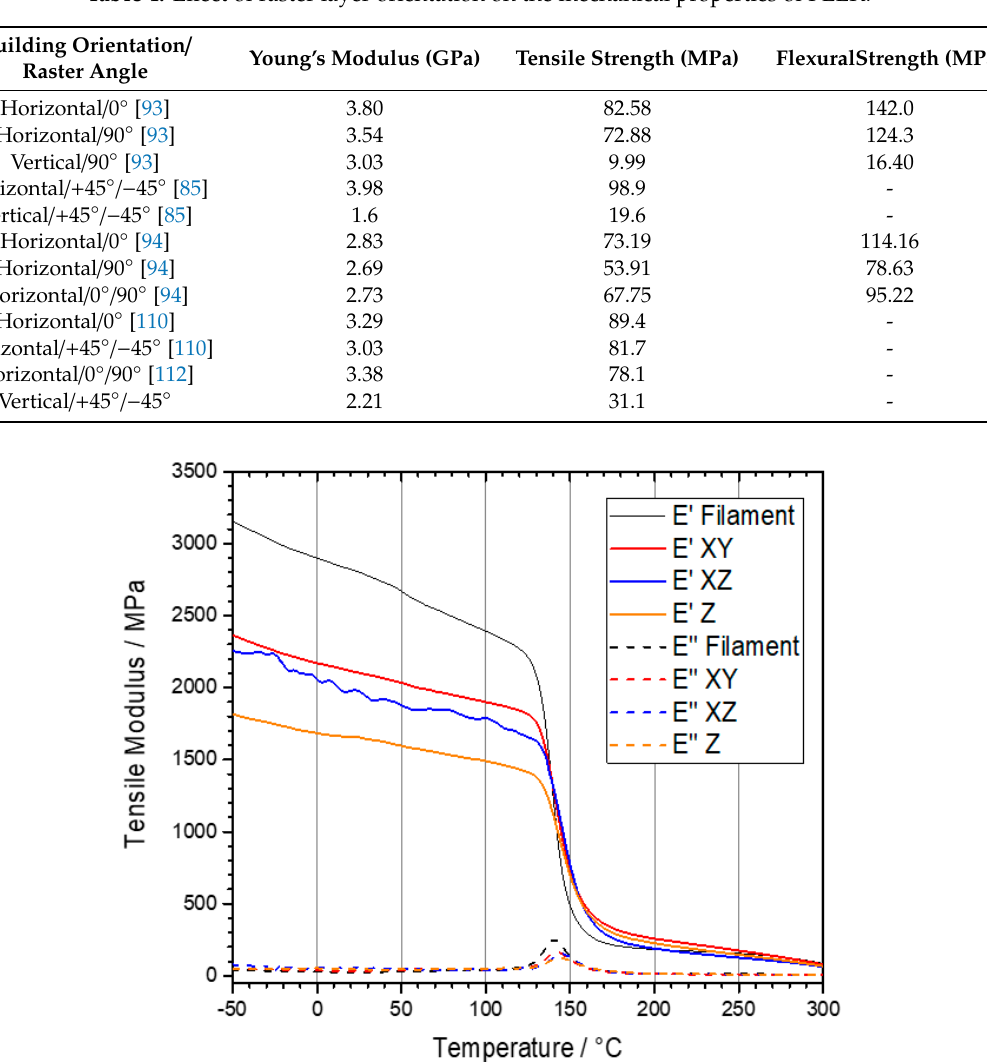
Table 4. Effect of raster layer orientation on the mechanical properties of PEEK.